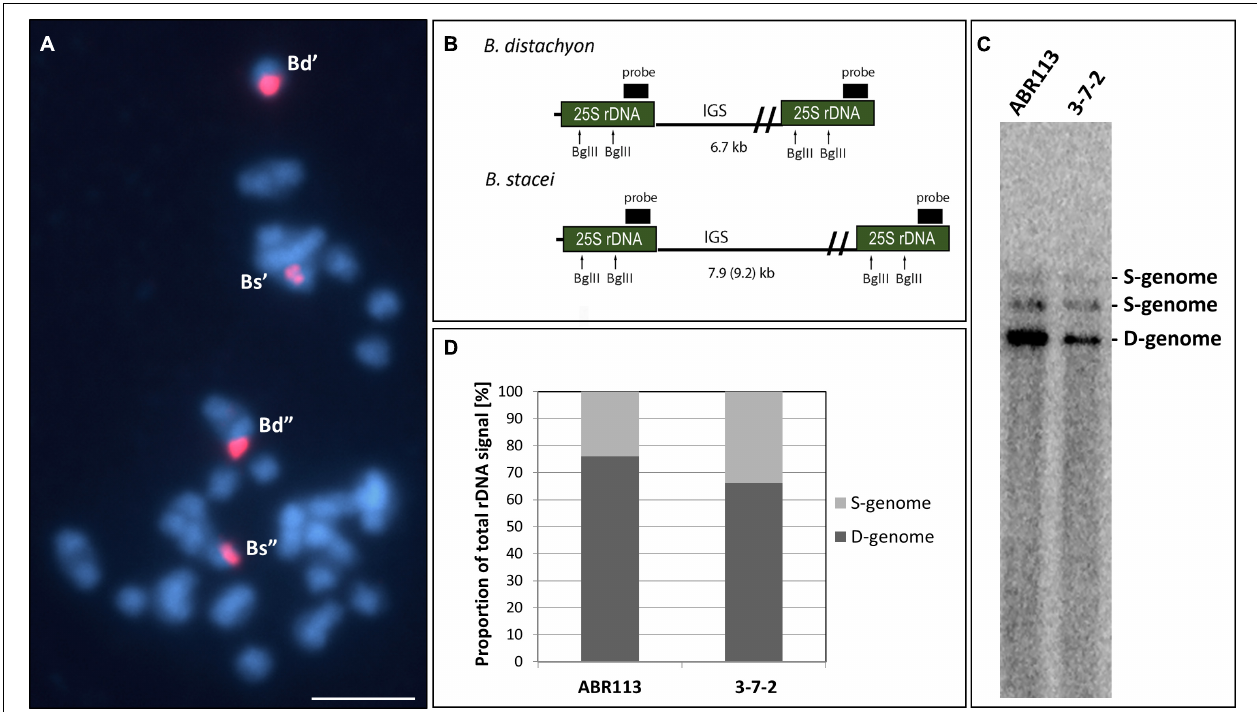
FIGURE 1 | The structure of the 35S rRNA gene loci in B. hybridum genotype 3-7-2. (A) FISH mapping of 25S rDNA (red fluorescence) in the highly condensed metaphase chromosomes of the genotype 3-7-2. Chromatin was stained with DAPI (blue fluorescence). Scale bar = 5 µ m. (B) The Bgl II restriction maps in progenitor B. distachyon and B. stacei rDNA units. For simplicity, only the 25S rRNA genes are shown. (C) Southern blot hybridization of the genomic DNAs from the genotypes 3-7-2 and ABR113 (control) subjected to restriction with Bgl II. The blot was hybridized with a 220-bp-long fragment of 25S rDNA. (D) The quantification of 35S rDNA homeologs. The ancestral rDNA contributions are denoted as the proportion of the D- or S-genome-specific signals to the total rDNA